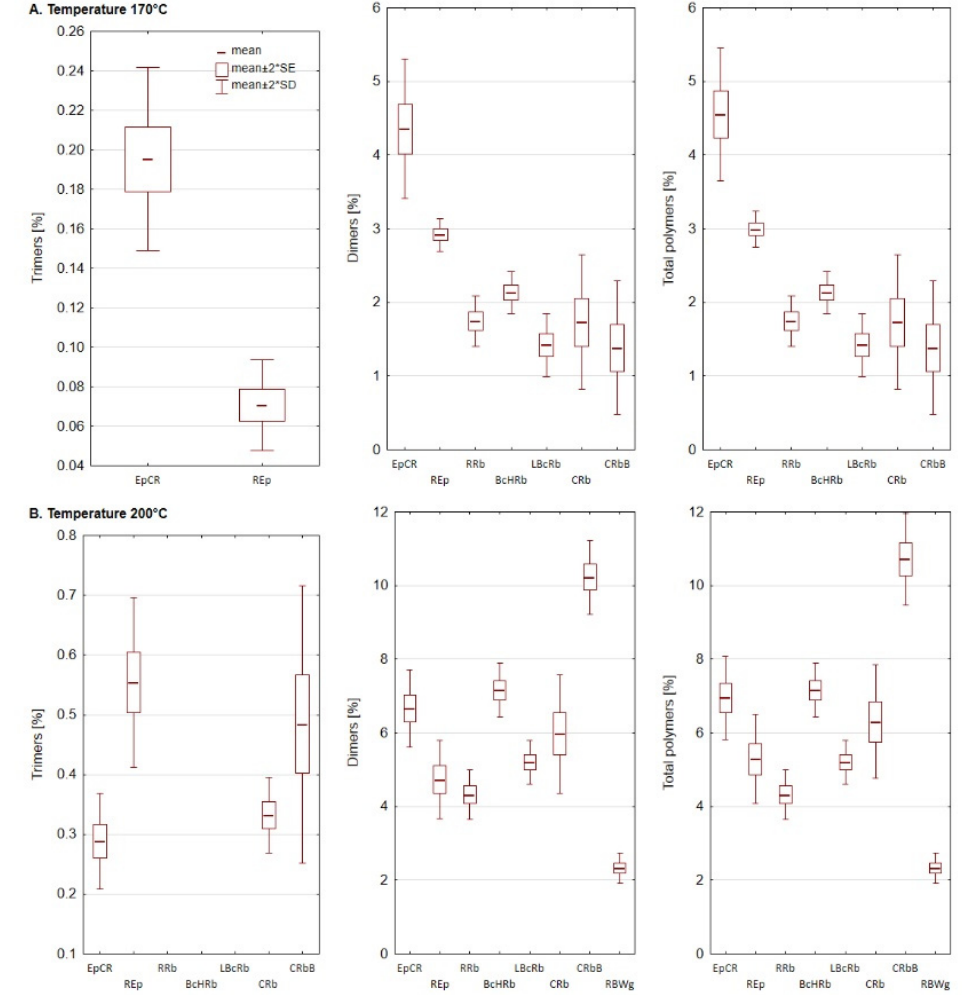
Figure 2. The share of dimers and trimers of triacylglycerols (TAG) in samples of oil blends heated at 170 ( A ) and 200 °C ( B ). SD—standard deviation, SE—standard error. Composition of blends is shown in Table 1.